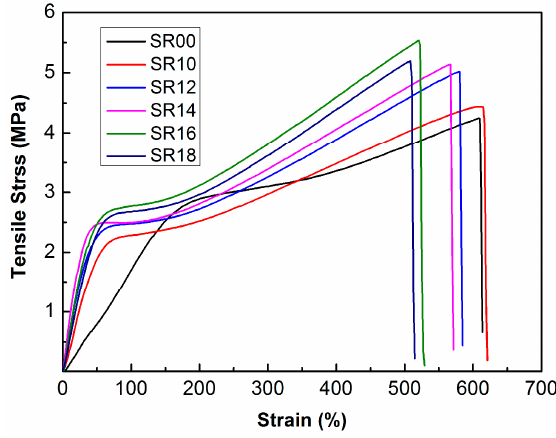
Figure 4. Representative stress-strain curves of SR composites. Table 2. Mechanical parameters and density of SR composites.